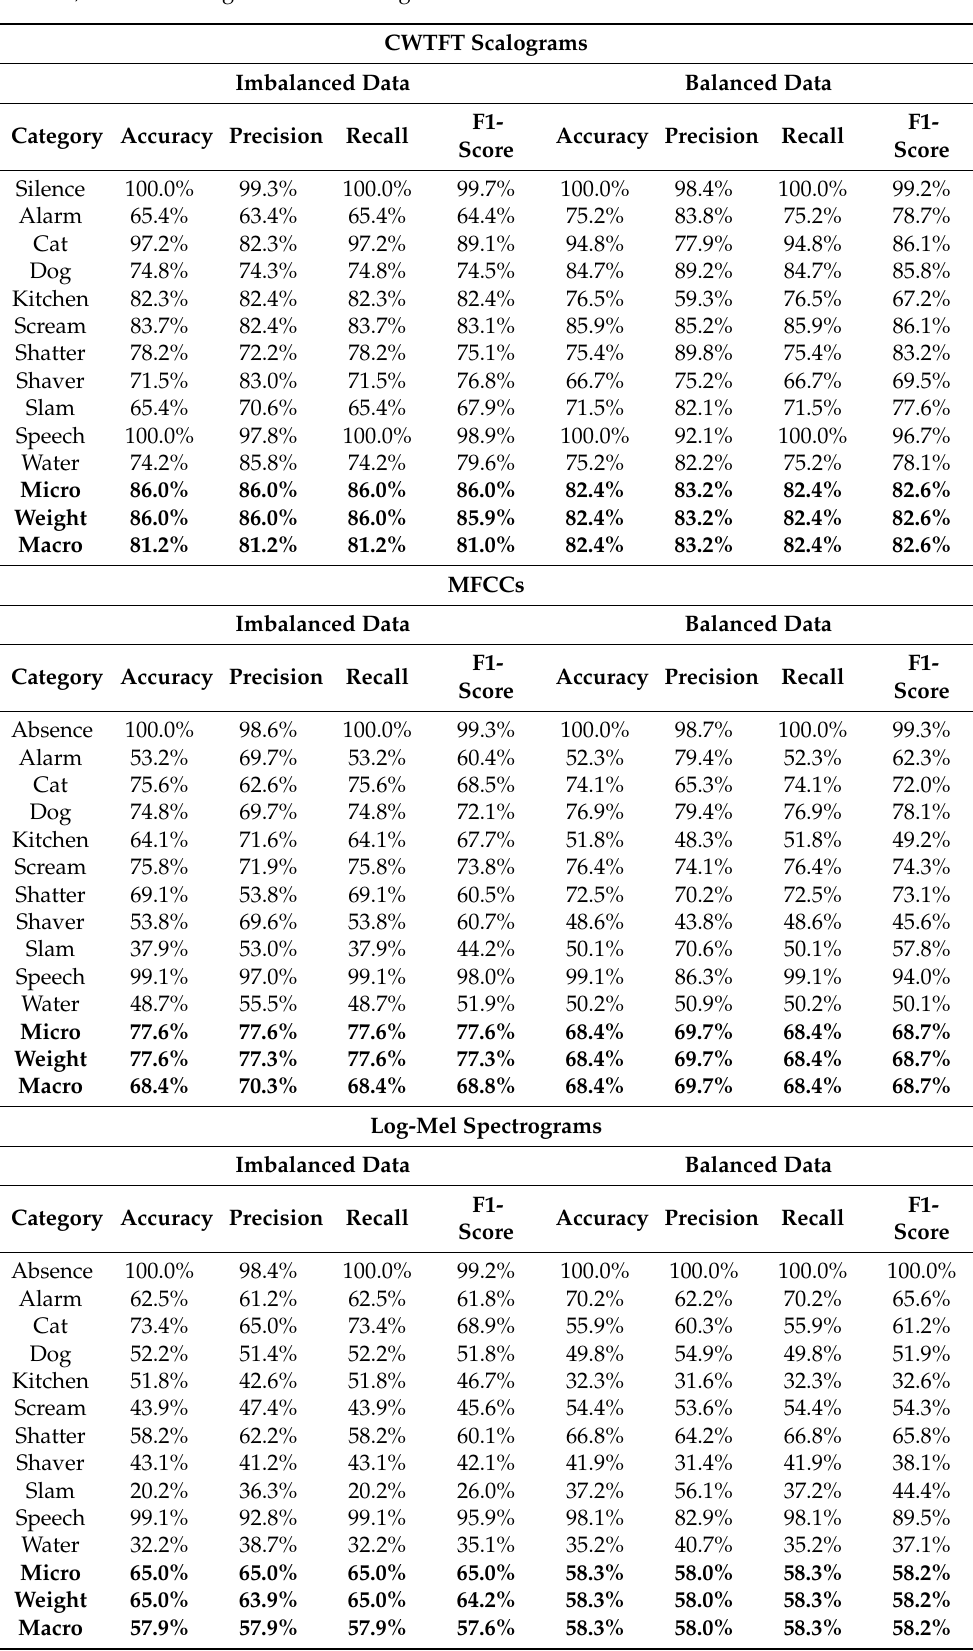
Table 3. Per-level comparison between imbalanced and balanced data between different types of features, with an average of three training